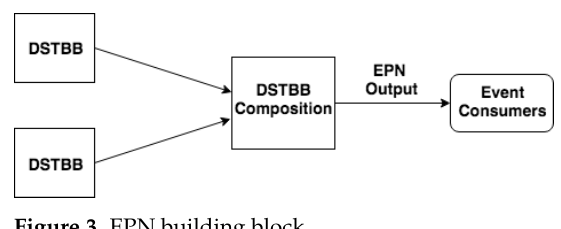
Figure 3. EPN building